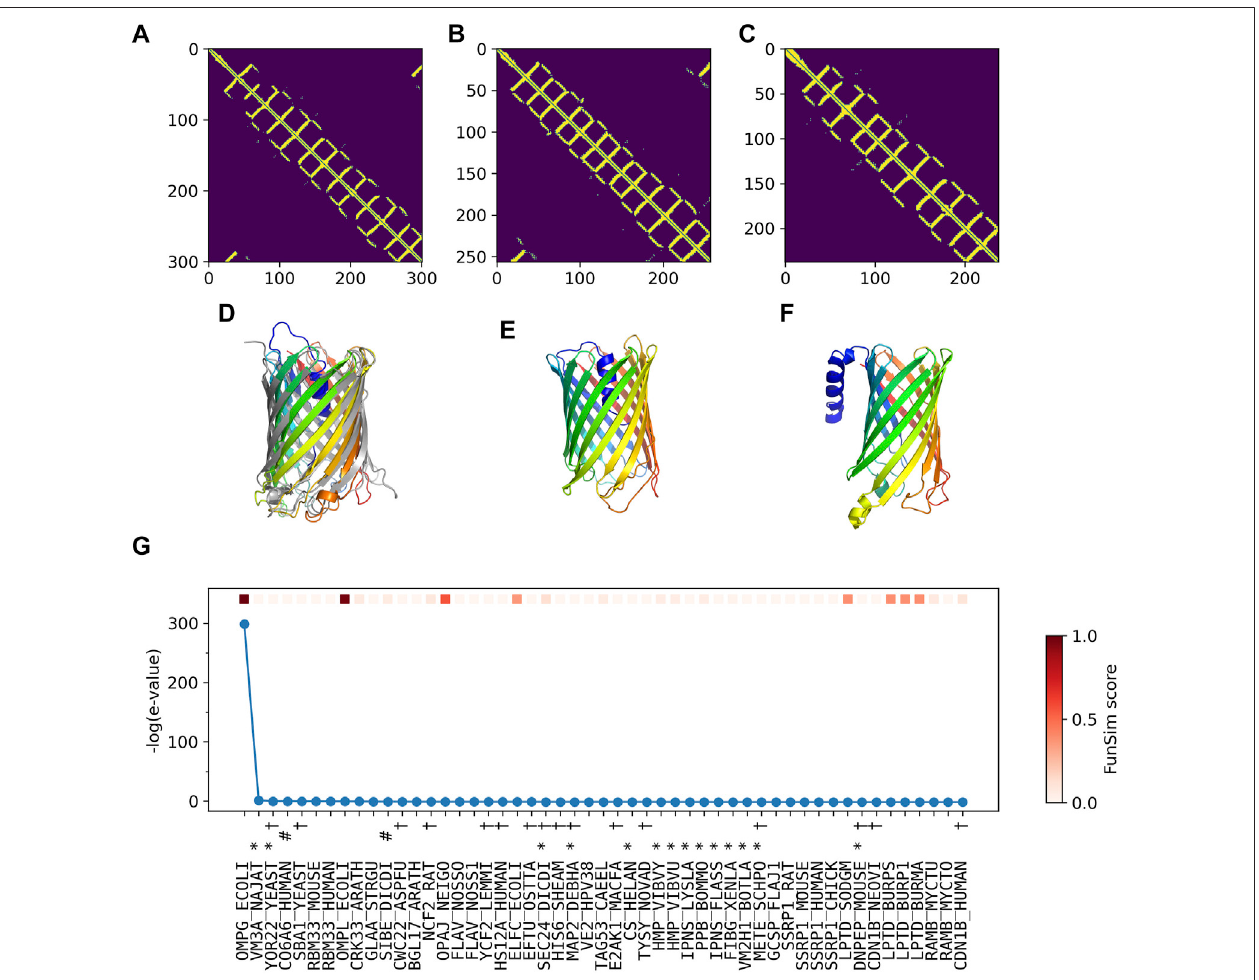
FIGURE5 | GO prediction byContactPFP for outer membraneporinG (P76045). The fi rst three panels (A – C) and the subsequent panels inthe second row (D – F) arepredictedresiduecontactsandresultingproteinstructuremodels. (A) Thepredictedcontactmapsofthequery,OMPG_ECOLI(P76045).Residuepairspredictedto be in contact are shown in yellow. (B) The predicted contact maps of YAIO_ECOLI (Q47534), the most similar contact map with the GR-align score of 0.733 (C) The predictedcontactmapsofNANC_ECOL6(P69856).ThesecondclosestcontactmapwiththeGR-alignscoreof0.658.GOtermsofthesetwoproteinswereused fortheprediction. (D) ThepredictedstructureofOMPG_ECOLI (P76045)wasgeneratedbytrRosetta(rainbow) superimposed withPDBstructure 2X9K(gray).Theroot meansquaredeviation(RMSD)ofthe modeltothe nativeis3.63 Å. (E) The predicted structureofYAIO_ECOLI (Q47534) wasgenerated bytrRosetta (rainbow).Forthis protein, no experimental structure has been reported. (F) The predicted structure of NANC_ECOL6 (P69856) was generated by trRosetta (rainbow). No experimental structurewasreportedforthisprotein. (G) ThetophitsforOMPG_ECOLIbyPSI-BLASTsearchagainstSwiss-Prot. Thequeryitselfisshowninthe fi